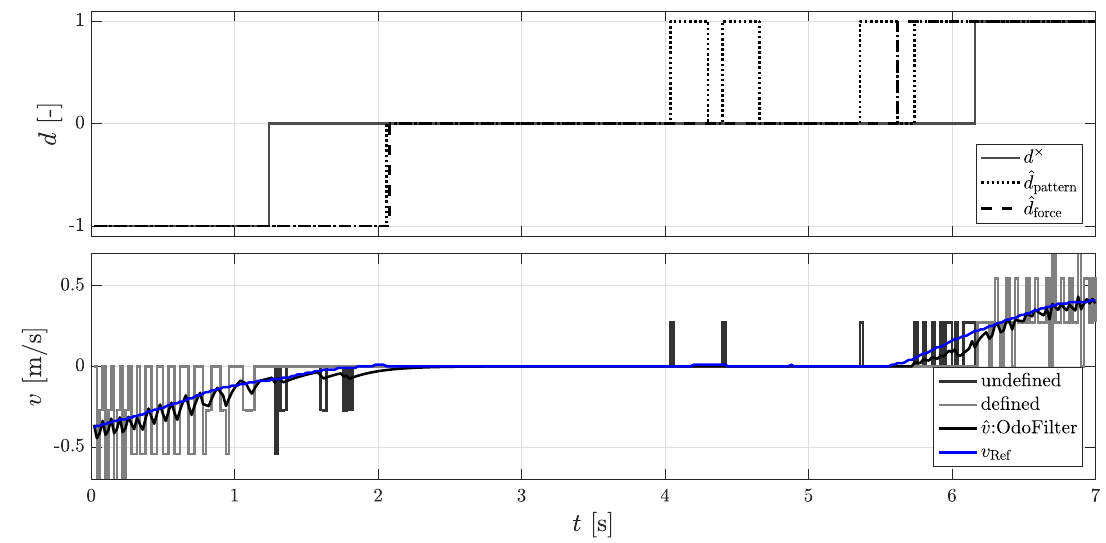
Figure 2. ( Top ): The rolling directions of the Delta-Wheel-Pulse-Counts (DWPCs) signal d × , the pattern recognition method ˆ d pattern , and the force equilibrium method ˆ d force ; ( Bottom ): Undefined and defined DWPCs and velocity of the OdoFilter using the new rolling directions